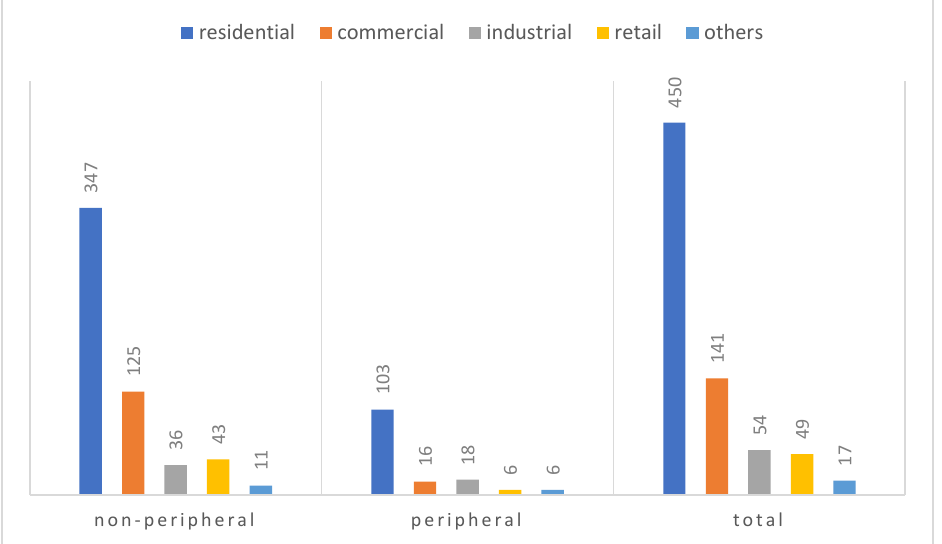
Figure 4. Comparison of the distribution of coworking spaces related to the type of land use for peripheral and non-peripheral areas, and in total.